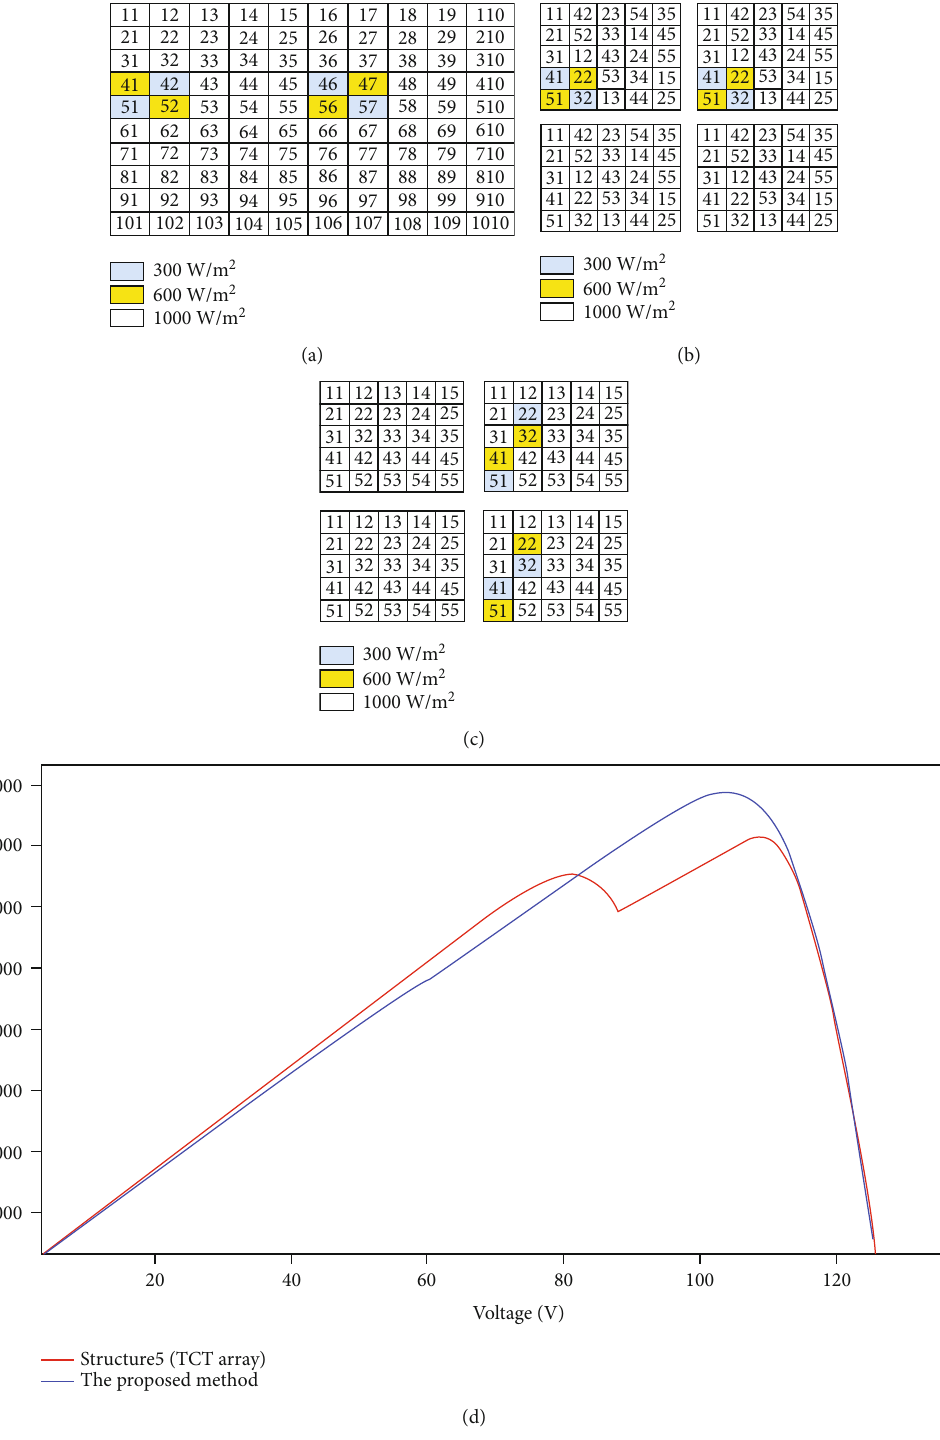
Figure 10: First shading pattern. (a) TCT array. (b) The proposed method before recon fi guration. (c) The proposed method after recon fi guration. (d) The PV array characteristics for the TCT array and the proposed